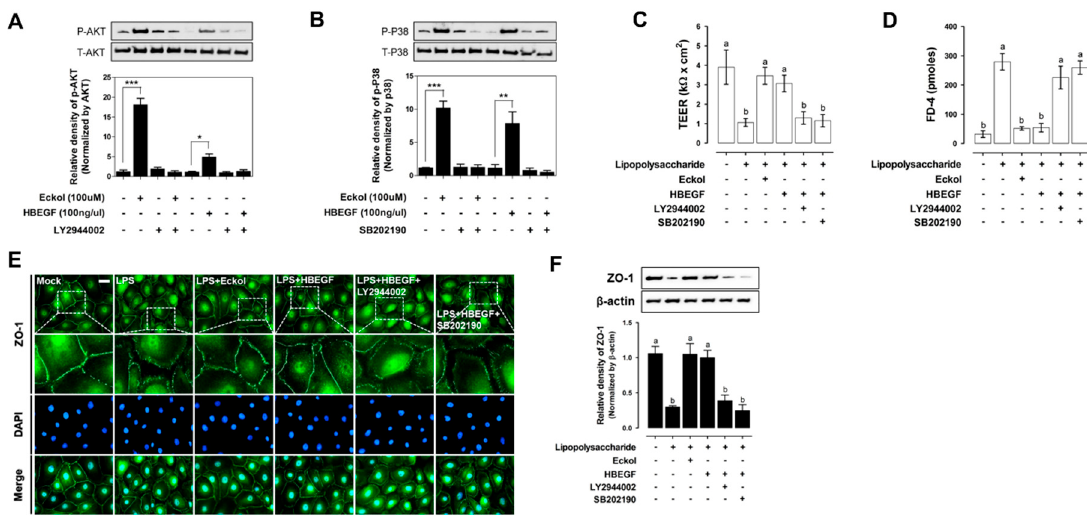
Figure 5. E ff ects of eckol on intestinal barrier function. Activation of PI3K / AKT ( A ) and P38 ( B ) signaling pathways in IPEC-J2 cells treated with eckol and HBEGF for 2 h under lipopolysaccharide (LPS) challenge. AKT (Ser473) and P38 (Thr180 / Tyr182) phosphorylation was evaluated by Western blotting. Protective e ff ects of eckol and HBEGF on intestinal barrier function in IPEC-J2 cells under LPS challenge, as determined by TEER quantification ( C ), and the permeability of fluorescein isothiocyanate-FD-4 ( D ) (n = 3). ZO-1 expression upon eckol and HBEGF treatment under LPS challenge was evaluated by immunofluorescence analysis ( E ) and Western blotting ( F ). Nuclei were stained with 4’,6-diamidino-2-phenylindole (DAPI). IPEC-J2 cells were treated with eckol and HBEGF under LPS challenge with or without PI3K / AKT (LY2944002) and P38 (SB202190) inhibitors. Error bars indicate standard error of triplicate analyses. * p < 0.05, ** p < 0.01, *** p < 0.001. Lower-case letters indicate significant di ff erences among treatments that are based on Duncan’s multiple range